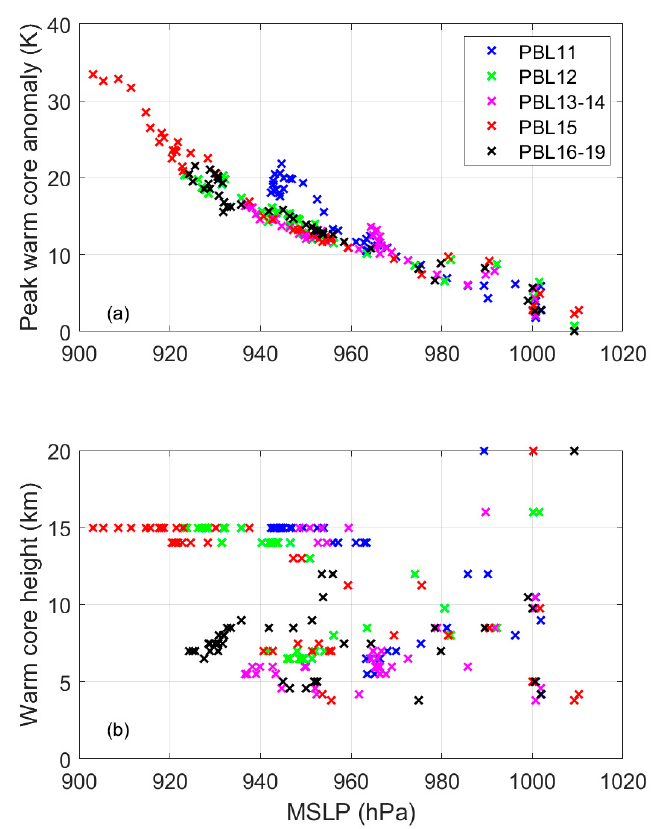
Figure 12. Plots of ( a ) peak warm-core anomaly and ( b ) warm-core height as a function of the minimum sea level pressure (MSLP) in the idealized HWRF simulations with five different PBL schemes.